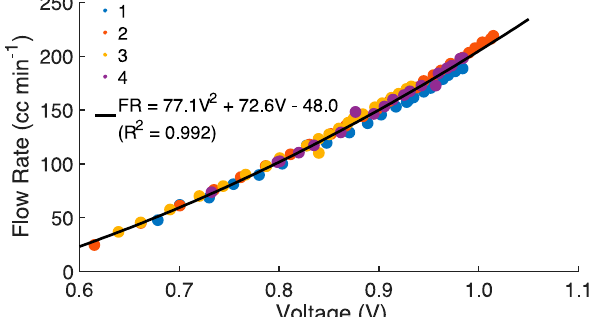
Figure A4. Flow sensor calibration data. Volumetric flow rate of air sampled through ABCD plotted as function of voltage output from four different Omron D6F differential pressure sensor units. A quadratic regression equation is derived for the aggregate data collected from all four sensors, and is shown with the corresponding coefficient of determination (R 2 ).